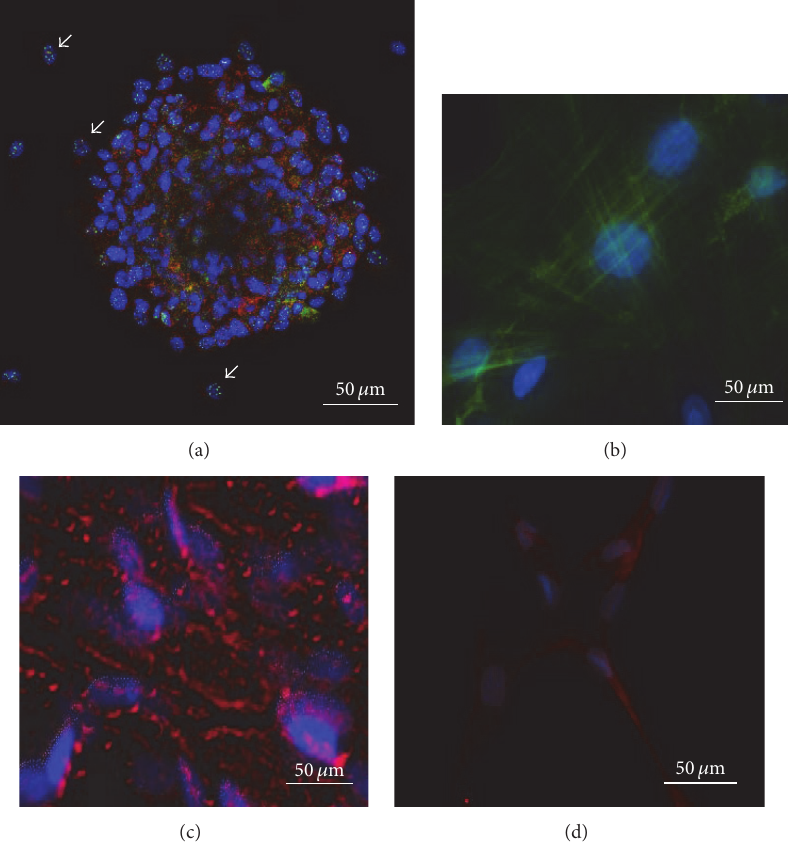
Figure 1: Muse-AT cells can differentiate into mesodermal, endodermal, and ectodermal cell lineages. Muse-AT cells can grow in suspension, forming spheres or cell clusters as well as individual cells (see white arrows) both expressing characteristic pluripotent stem cell markers, such as Oct4 (Texas Red) and TRA-1-60 (Green Fluorescence GFP), while nuclei were stained with DAPI (blue) (a); myogenic differentiation medium; the formation of myocytes (mesodermal origin) was detected using an anti-human MSA antibody (b); hepatogenic differentiation medium; formation of hepatocytes (endodermal origin) was detected using an anti-cytokeratin 7 antibody (c); neural differentiation medium; neural-like cells (ectodermal origin) were detected by immunofluorescence using an anti-human MAP2 antibody (d). Nuclei were stained with DAPI (blue) (original magnification 600x). (b)–(d) From Figures 3 (C), 4 (C), and 5 (D)